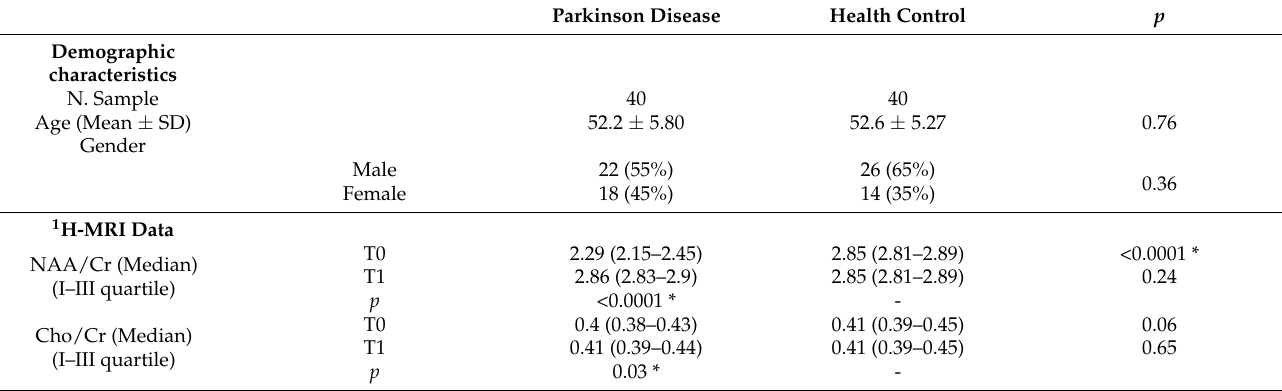
Table 1. Demographic and imaging characteristics of de novo PD patients and HC groups.